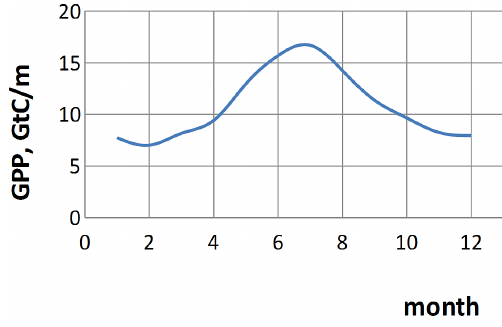
Figure 2. Seasonal cycle of the gross primary production (GPP), as calculated using Eqs. (4)–(7).